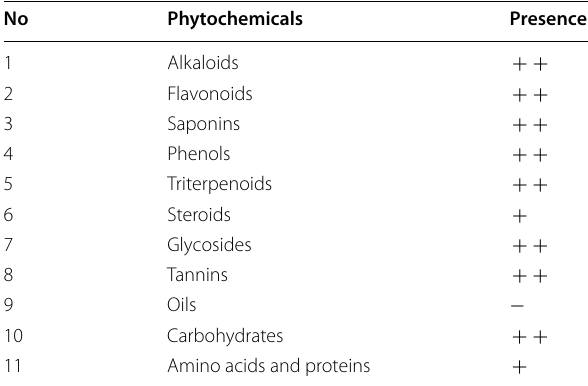
Table 1 Phytochemicals of the crude methanolic extract of S. mahagoni (L.) leaves